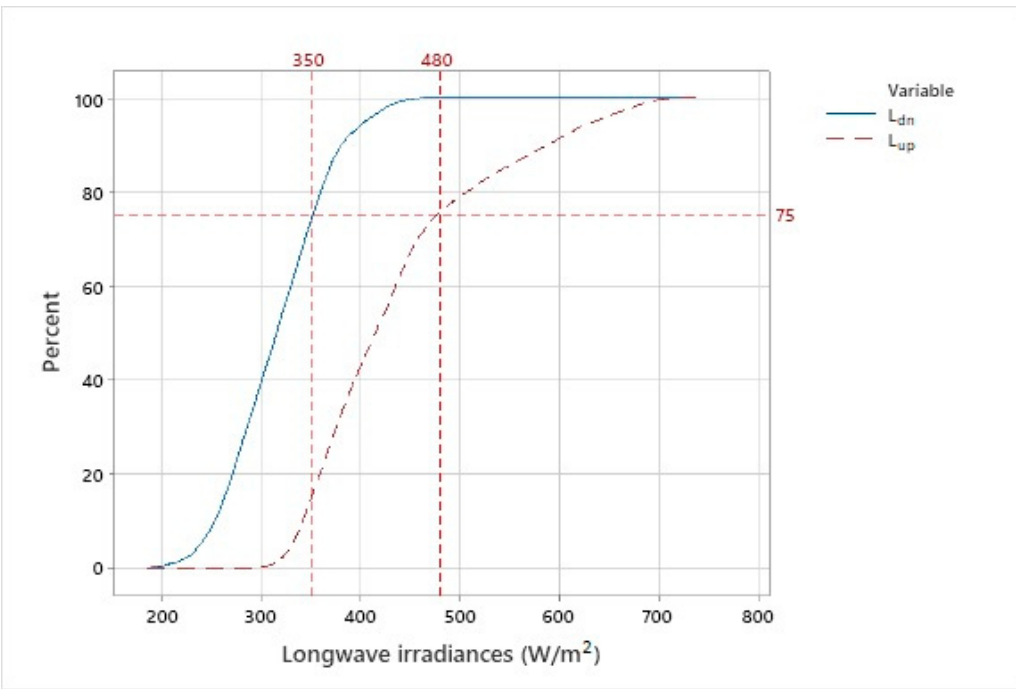
Figure 8. Marginal plot of the hourly L dn and L up with the annual frequency distributions of the two variables at Athalassa.